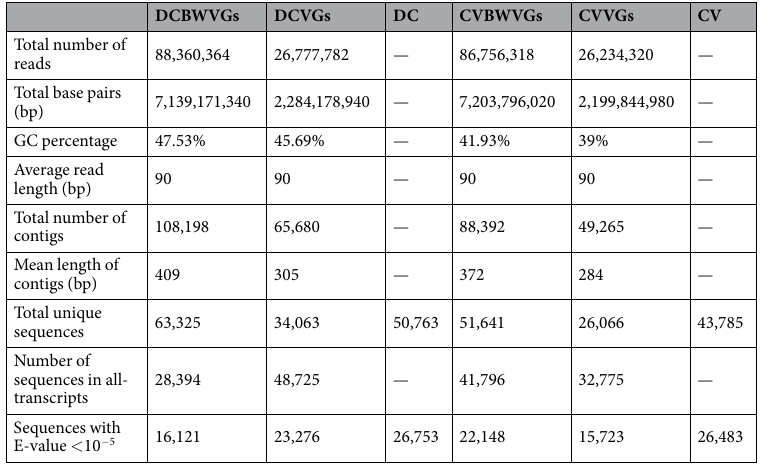
Table 1. Summary of the transcriptomes. DCVGs: D . collaris venom glands; DCBWVGs: D . collaris bodies without venom glands; CVVGs: C . vestalis venom glands; CVBWVGs: C . vestalis bodies without venom